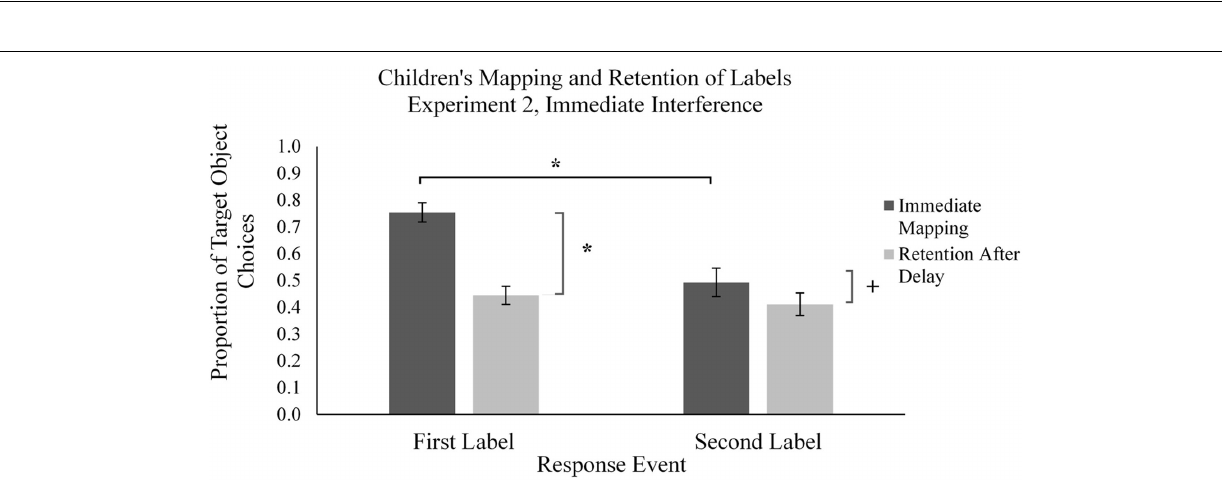
FIGURE 6 | Mean proportion of children’s target novel object choices in the learning phase (immediate mapping) and testing phase (retention after delay) for first and second labels in the Immediate Interference condition in Experiment 2. Error bars represent one standard error, * indicates significant difference in performance, p < 0.05, + indicates marginally significant difference, p =